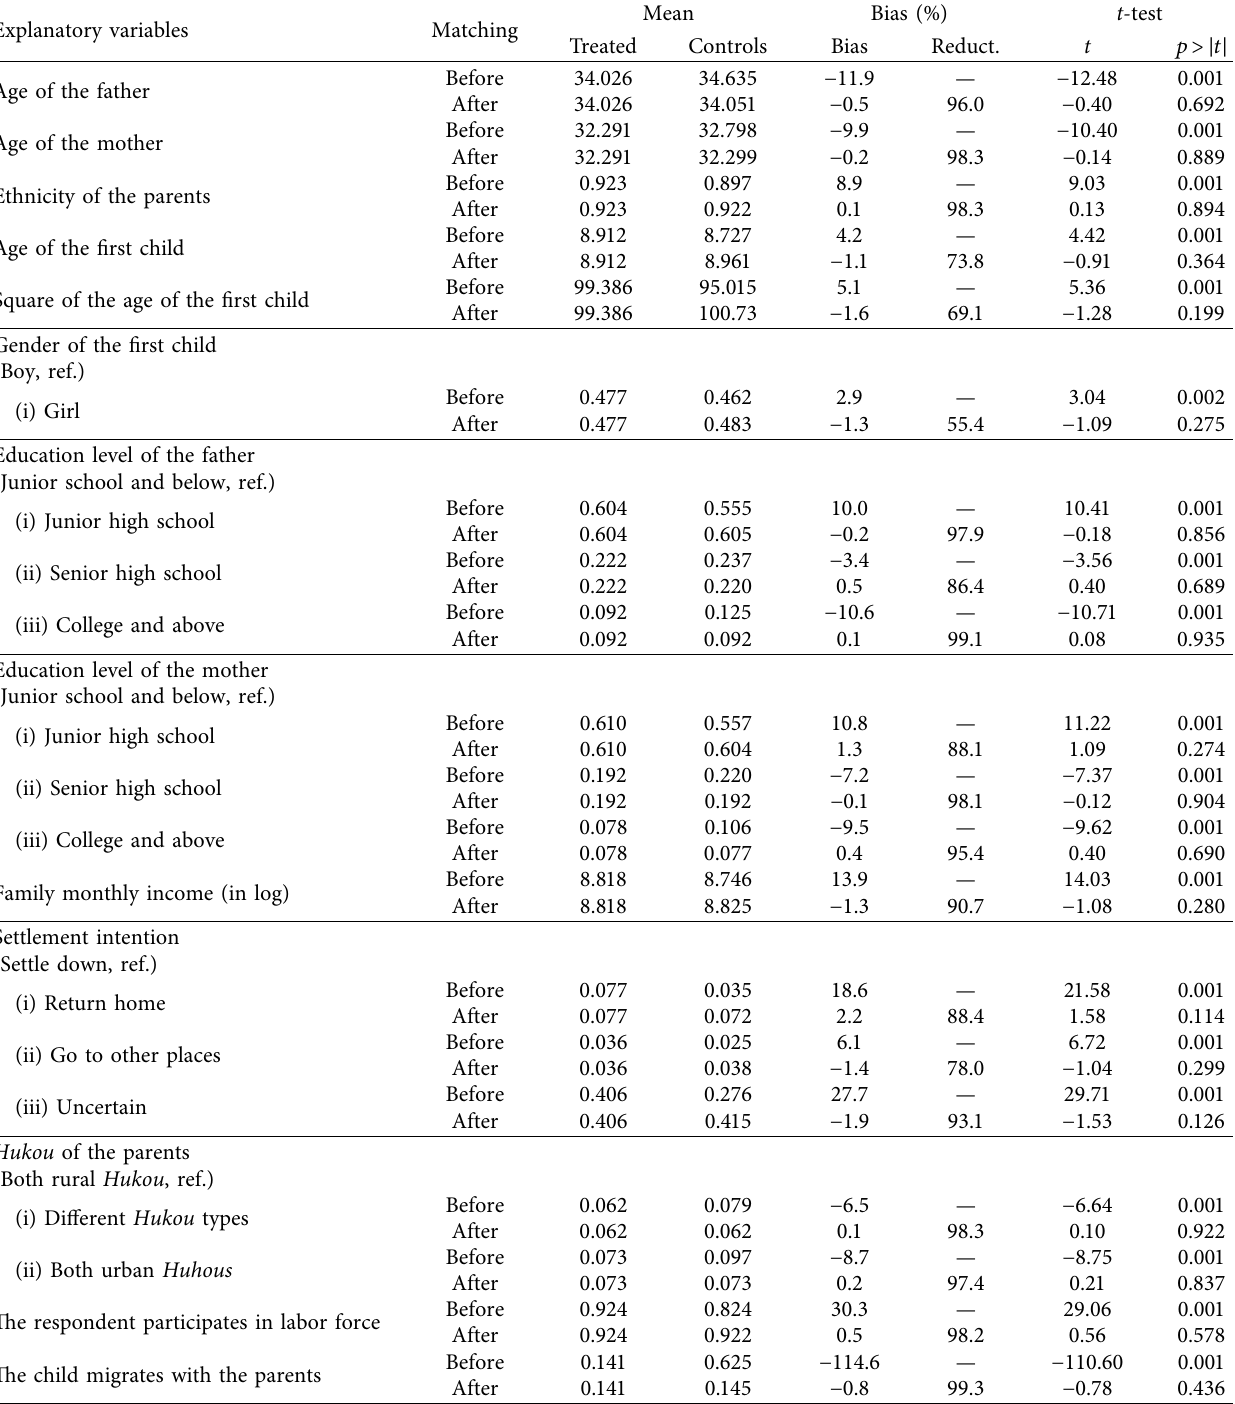
Table 3: Matching quality test: balancing